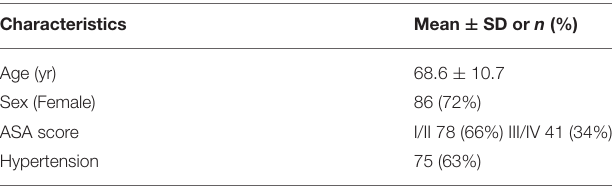
TABLE 1 | Baseline characteristics of patients undergoing cataract surgery.